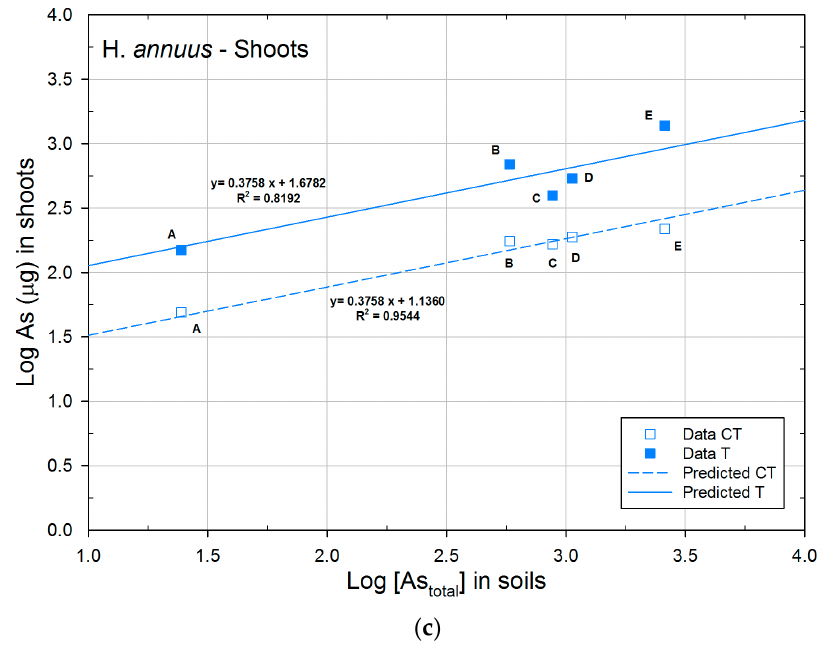
Figure 4. Freundlich-like equation for the total accumulation of B. juncea ( a ), L. albus ( b ), and H. annuus ( c ) in control (CT) and phosphate treated (T) soils.